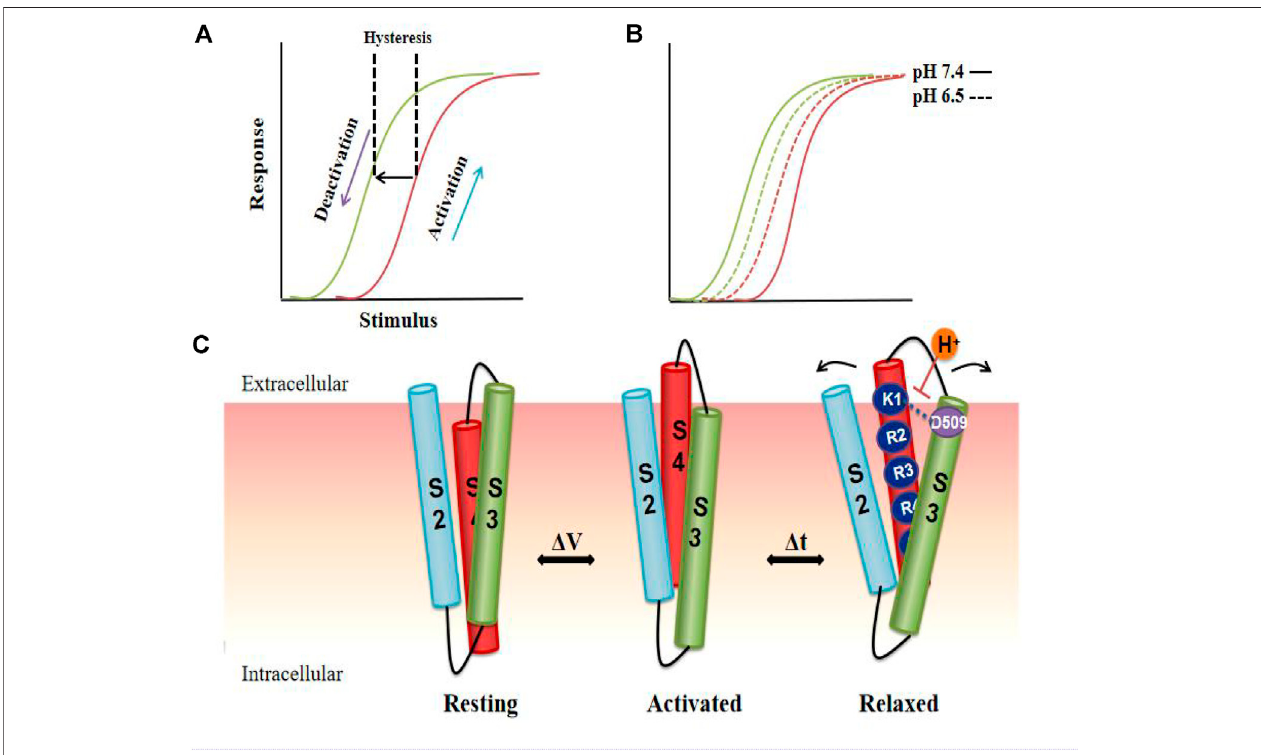
FIGURE 5 | Model of VSD relaxation. In the hERG channel, depolarization activates the channel, and then repolarization causes the channel to deactivate and the VSDtoenterarelaxedstate,resultinginhysteresis. (A) ComparedtopH7.4( solidline ),theacidicpH( dottedline )shortensthehysteresisbehaviorofthechannel,thereby acceleratingthedeactivationprocess. (B) .Cartoonrepresentationofproposedrecon fi gurationsofS2,S3,andS4transmembranedomainsintheresting,activated,and relaxed states. S4 in VSD undergoes a conformational change from a stable resting state to a relaxed state due to the voltage change. Putative recon fi gurations associated with entering a relaxed state may involve the interaction of D509 with the positive external charge of S4. The neutralization of D509 or external protonation is predictedtodestabilizetheinteractions,therebydestroyingtherelaxedstate.Arrowsindicatethehypotheticalstructuralrearrangementsofthehelixduringtherelaxation process resulting from the interaction of the acidic residues in S2-S3 (C)